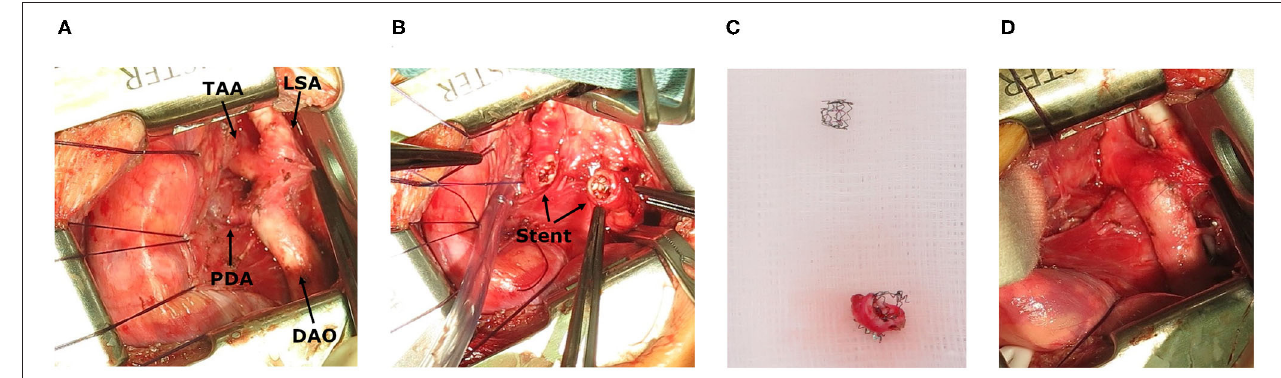
FIGURE 3 | Intraoperative images. (A) Situs after stent implantation, showing transverse aortic arch (TAA), left subclavian artery (LSA) and descending aorta (DAO) and persistent ductus arteriosus (PDA). (B) Stent in the isthmus region. (C) Resection of coarctation with stent. (D) Surgical result.